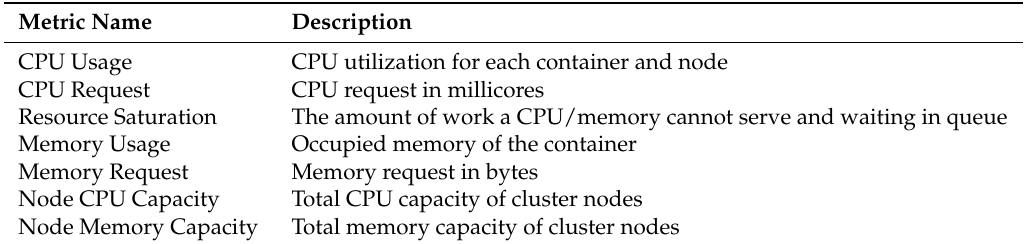
Table 1. Monitoring